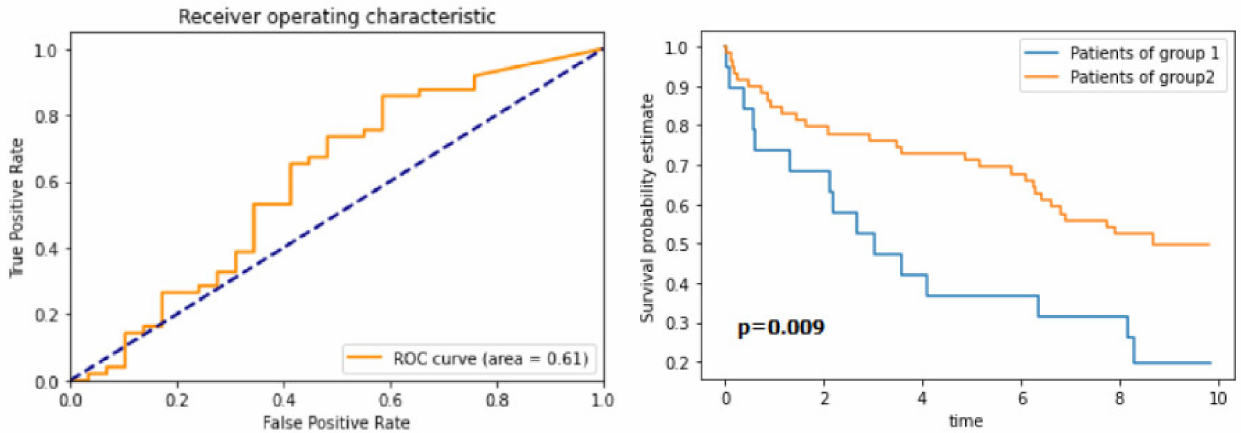
Figure 12. The ROC for the optimal cut-off value of the ICOS density ( left-image ), and the Kaplan–Meier curves for the survival analysis ( right-image ) (group 1 above threshold and group 2 below the